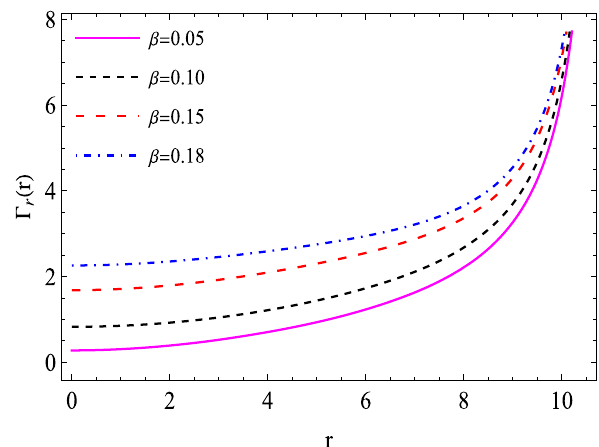
Fig. 6 The above figure shows the behavior of the adiabatic index ( (cid:20) r ) with respect to r for different β